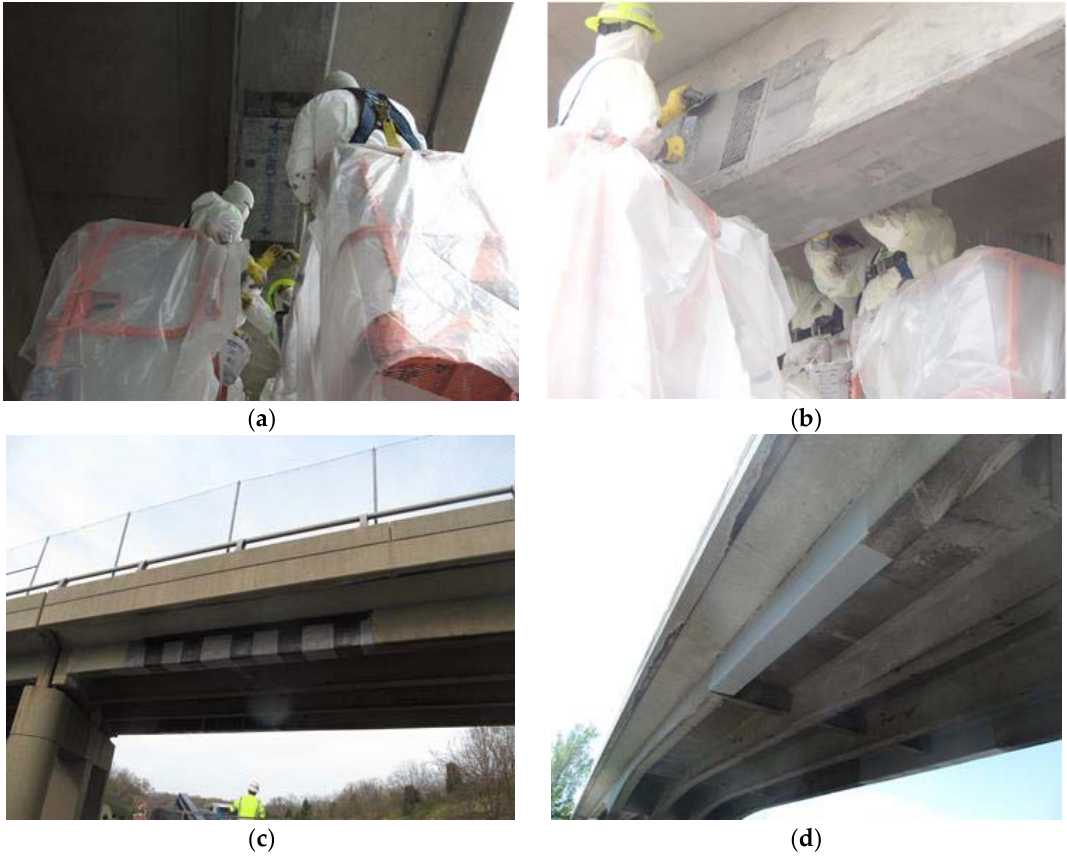
Figure 10. CFRP Strengthening ( a ) CRP applied to bottom surface; ( b ) Covering CRP on sides; ( c ) CFRP U-wraps and anchor strips applied over CRPs; ( d ) Ultraviolet (UV) protective coating applied over retrofit.